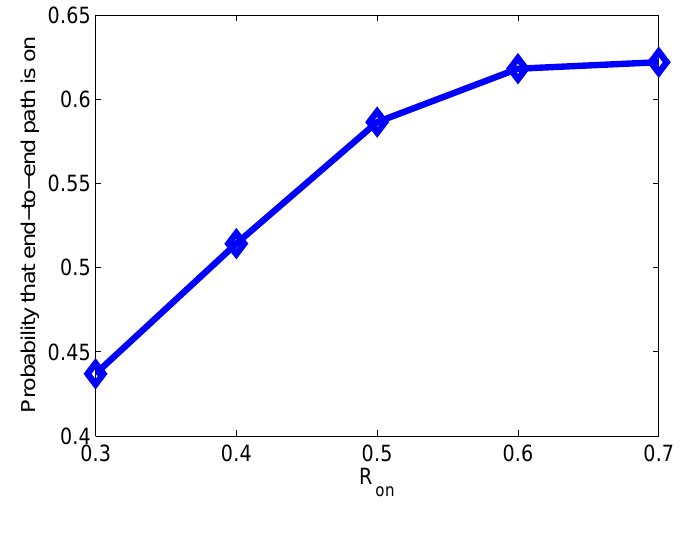
Figure 8. Average power consumption and average delay versus R